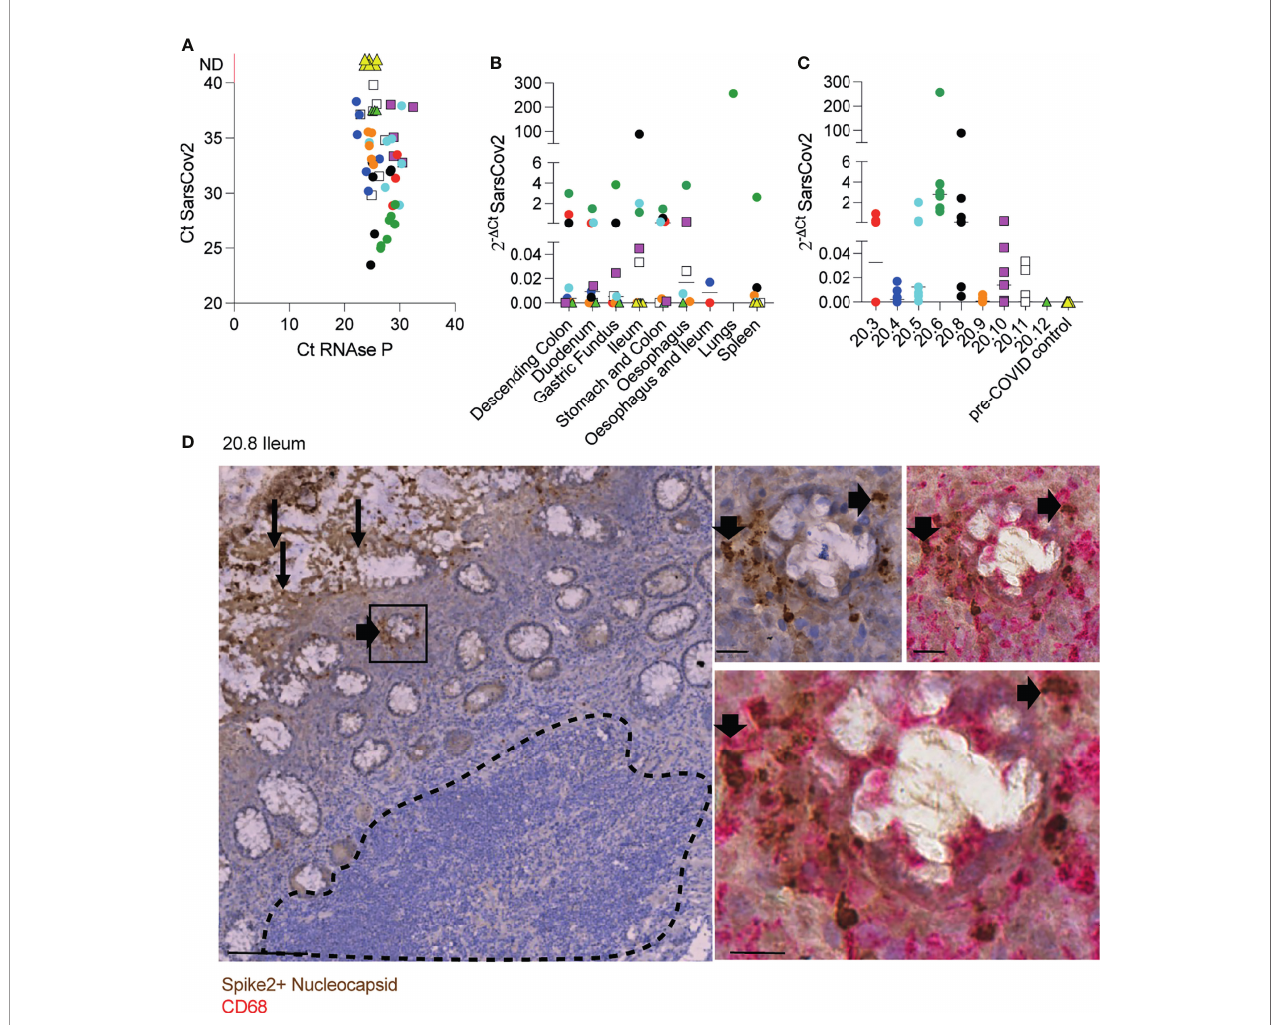
FIGURE 1 | Identi fi cation of SARS-CoV-2 in tissue samples along the GI tract. (A-C) Evaluation of SARS-CoV-2 presence using RT-qPCR in different FFPET samples from 9 COVID-19 deceased patients and 4 pre-COVID patients used as controls. Dots represent the viral RNA level from each sample and were coloured by patient. The lines represent the median values per organ (B) or patient (C) . (D) IHC for SARS-CoV-2 spike and nucleocapsid proteins in an ileal sample from patient 20.8 showing the virus presence in the epithelium (panel on the left) and sub-mucosal macrophages (panels on the right). Scale bar for image on the left: 100 m m. Sale bars for images on the right: 20 m m. The dashed line delimitates the